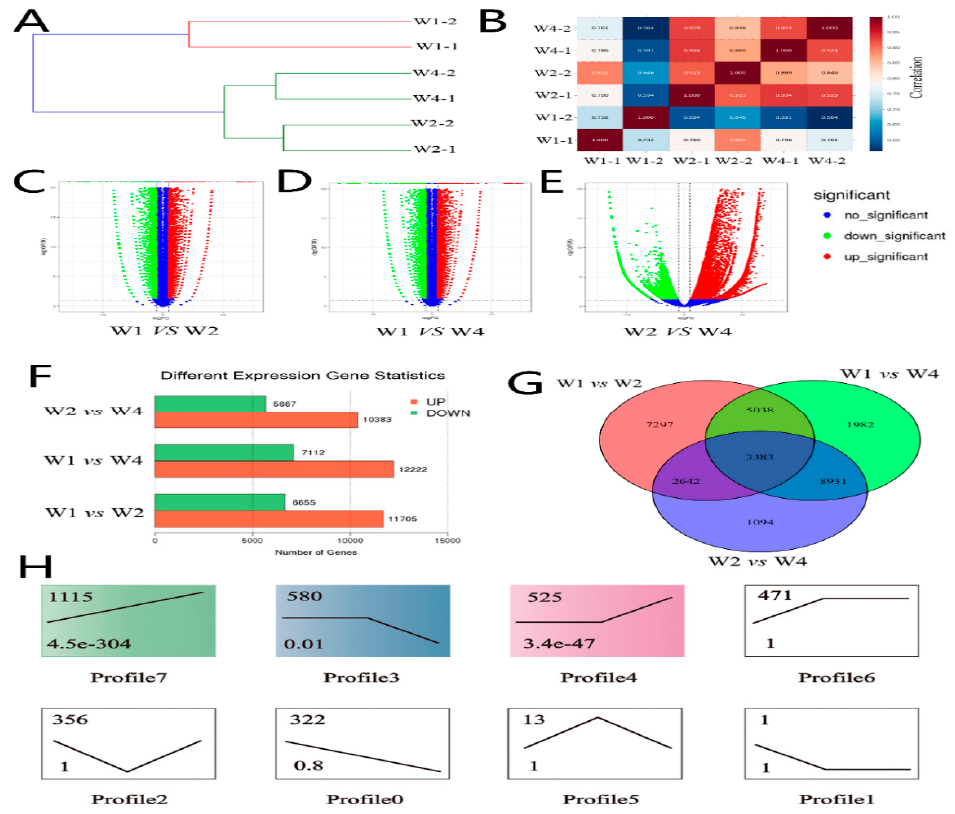
Figure 1. Identifying differentially expressed genes by transcriptome sequencing. ( A ) The hierarchical clustering was carried out for intergroup analysis correlation. ( B ) Sample correlation heat-map was performed according to the expression profiles for quality control. ( C – E ) The volcano plot of significant differentially expressed genes (DEGs) in three groups (W1, W2, and W3). Blue represents no significant difference. Green represents significantly downregulated DEGs. Red represents significantly upregulated DEGs. A total of 16,050, 19,334, and 18,306 DEGs were identified with pairwise alignment in intergroup. ( F ) The statistical graph of significant intergroup DEGs. Green represents downregulated genes. Red represents upregulated genes. ( G ) Venn diagram of differentially expressed genes in three groups. ( H ) Profile analysis of 3383 DEGs by STEM.